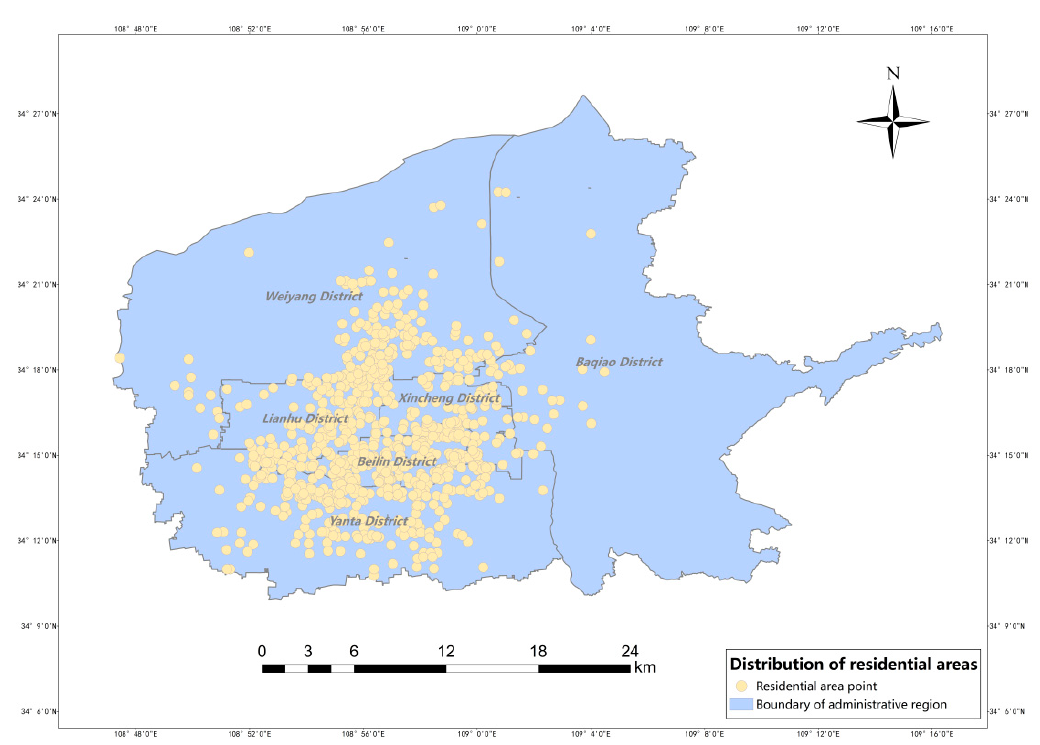
Figure 5. Distribution of residential